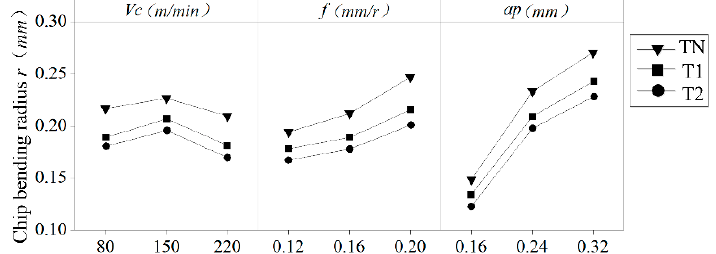
Figure 9. The single factor e ff ect of the cutting parameters on the chip curl Figure 9. The single factor effect of the cutting parameters on the chip curl radius. Figure 9. The single factor effect of the cutting parameters on the chip curl radius. Figure 9. The single factor effect of the cutting parameters on the chip curl radius.